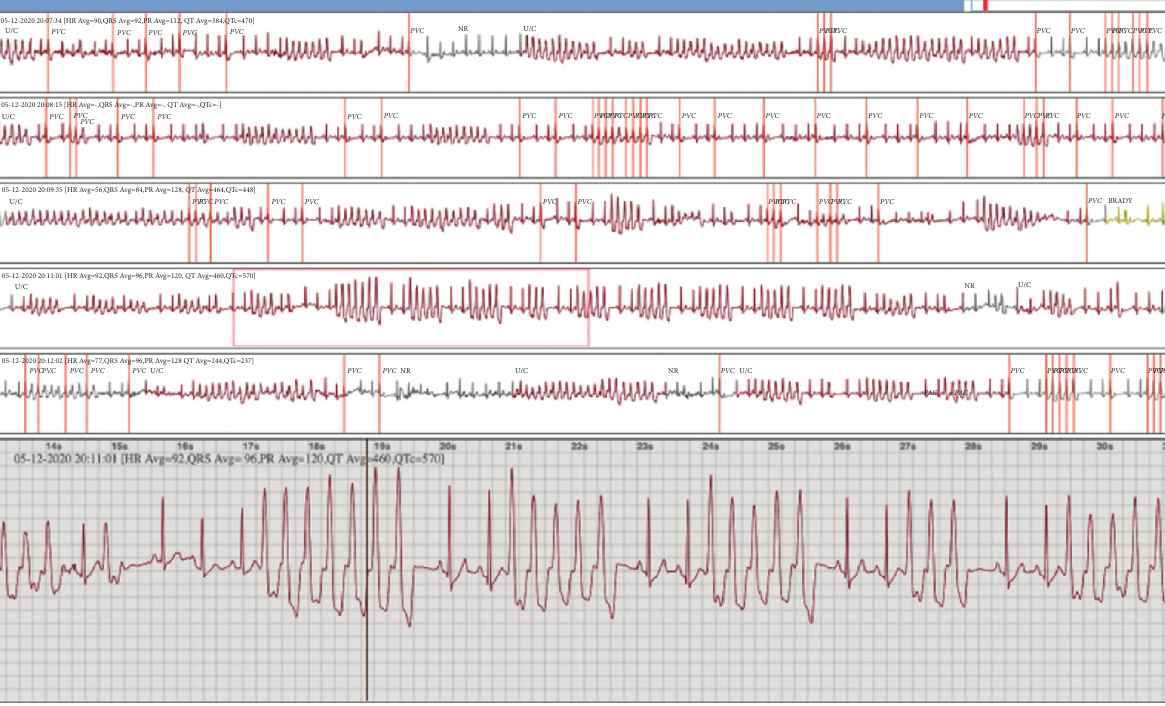
Figure 3: Nonsustained ventricular tachycardia detected by Spyder after 47 hours of